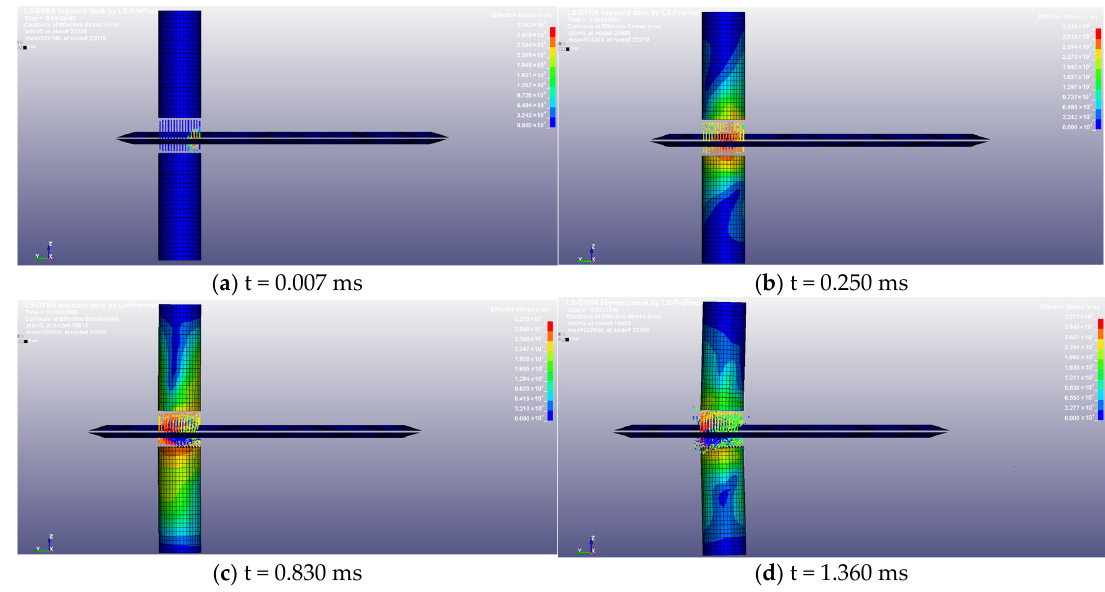
Figure 6. Postprocessing of the simulation. ( a ) Effective stress at 0.007 ms; ( b ) effective stress at 0.250 ms; ( c ) effective stress at 0.830 ms; and ( d ) effective stress at 1.360 ms.